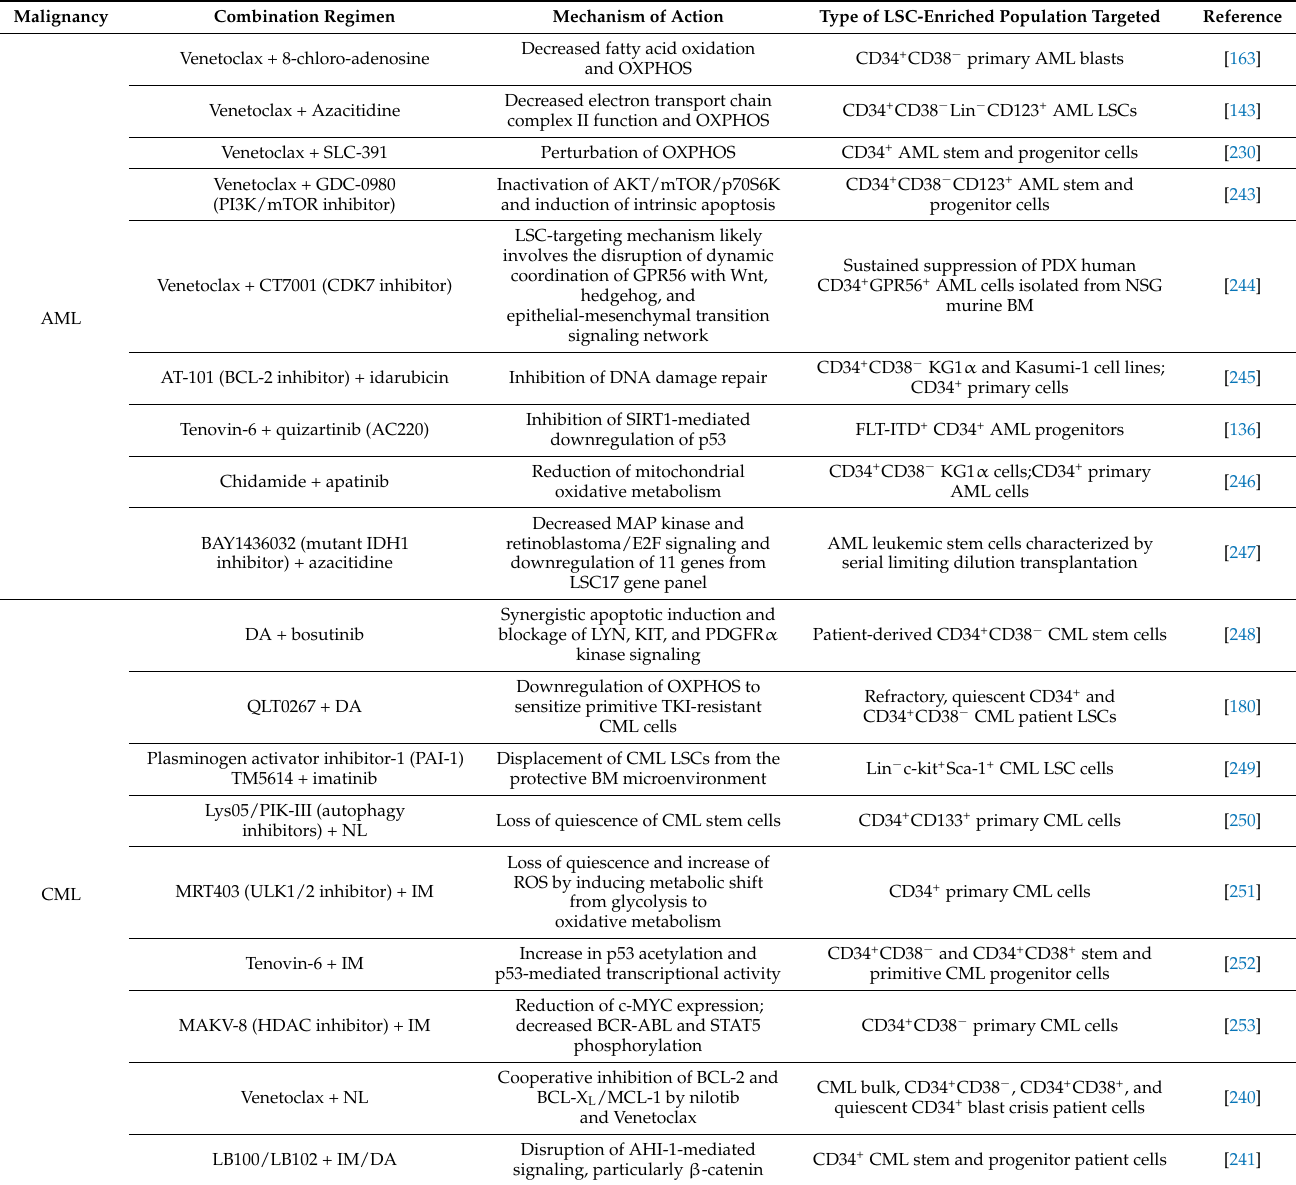
Table 3. Combination therapeutic approaches against LSC-enriched cells in AML and